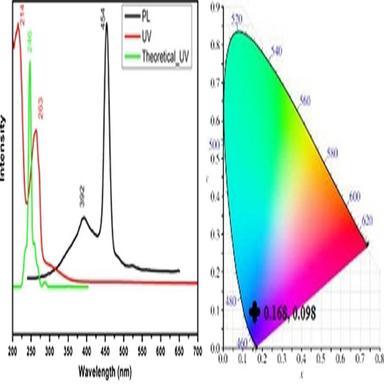
(a) UV–Vis spectrum of PCOH (b) PCM/TD CAM-B3LYP/GenECP UV–Vis spectrum PCOH (c) emission of PCOH at water solvent and CIE Chromaticity diagram of PCOH.